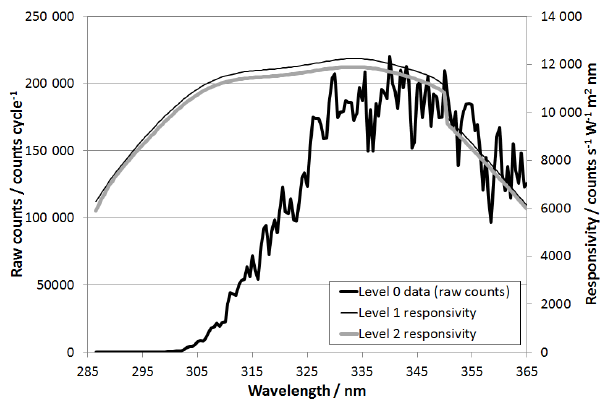
Figure 4. Example of Level 0 raw count data recorded by the Brewer no. 107 on 20 May 2007 at 13:20:07–13:25:18 UTC (on primary vertical axis) and Level 1/Level 2 responsivities of the in- strument for the same day (on secondary vertical